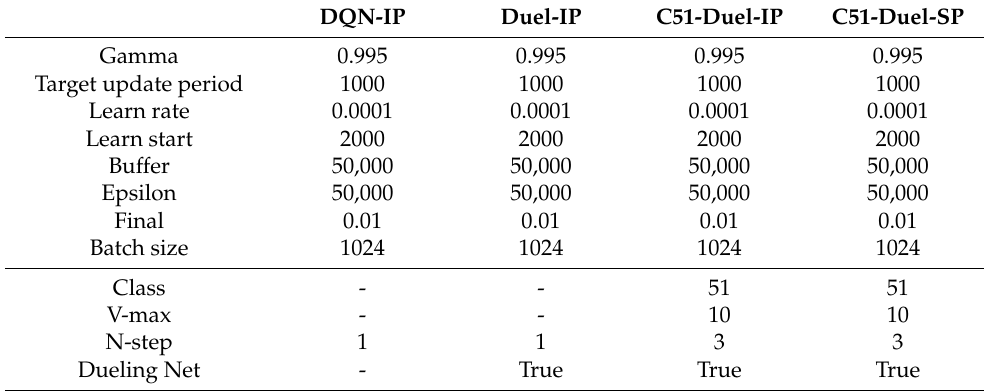
Table 1. Hyper-parameter Settings of DQN-IP, Duel-IP, C51-Duel-IP, C51-Duel-SP